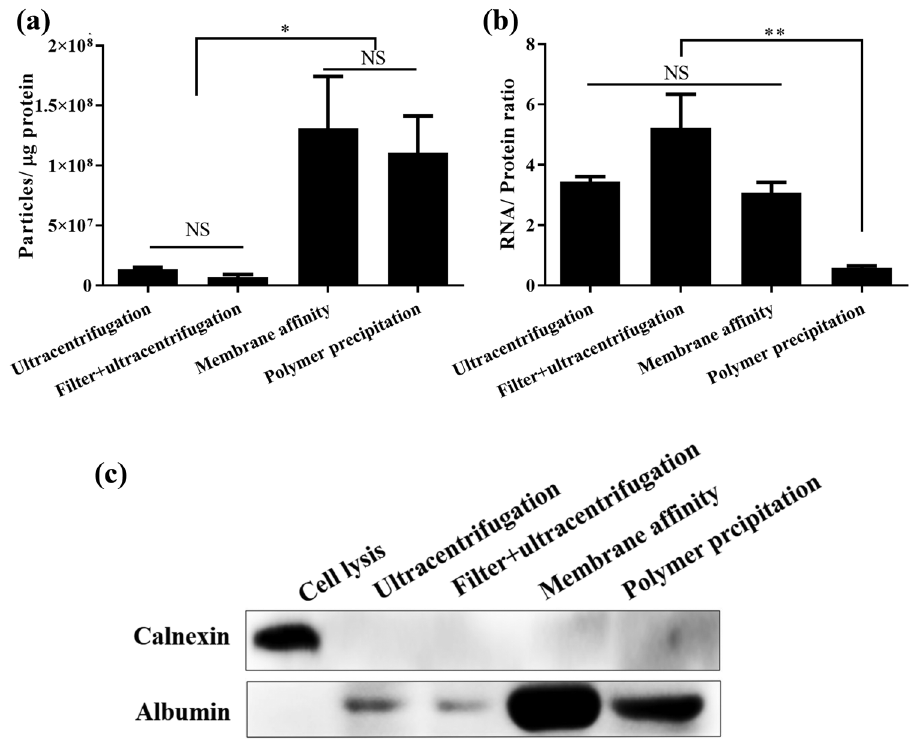
Figure 6: Purity of exosomes from di ff erent isolation procedures. ( a ) The exosomal purity presented as a ratio between particle concen - tration and protein. ( b ) Exosomal purity presented as the RNA ( µg ) to protein ( µg ) ratio. ( c ) Western blots for calnexin and albumin expression in each exosome preparation ( 20 µL of total exosomal protein was loaded ) . The results are the mean ± SE of the mean of three independent experiments. One - way analysis of variance ( ANOVA ) was used to assess the di ff erences among multiple groups, followed by Tukey ’ s post hoc test. *, P < 0.05. **, P < 0.01. NS, P >